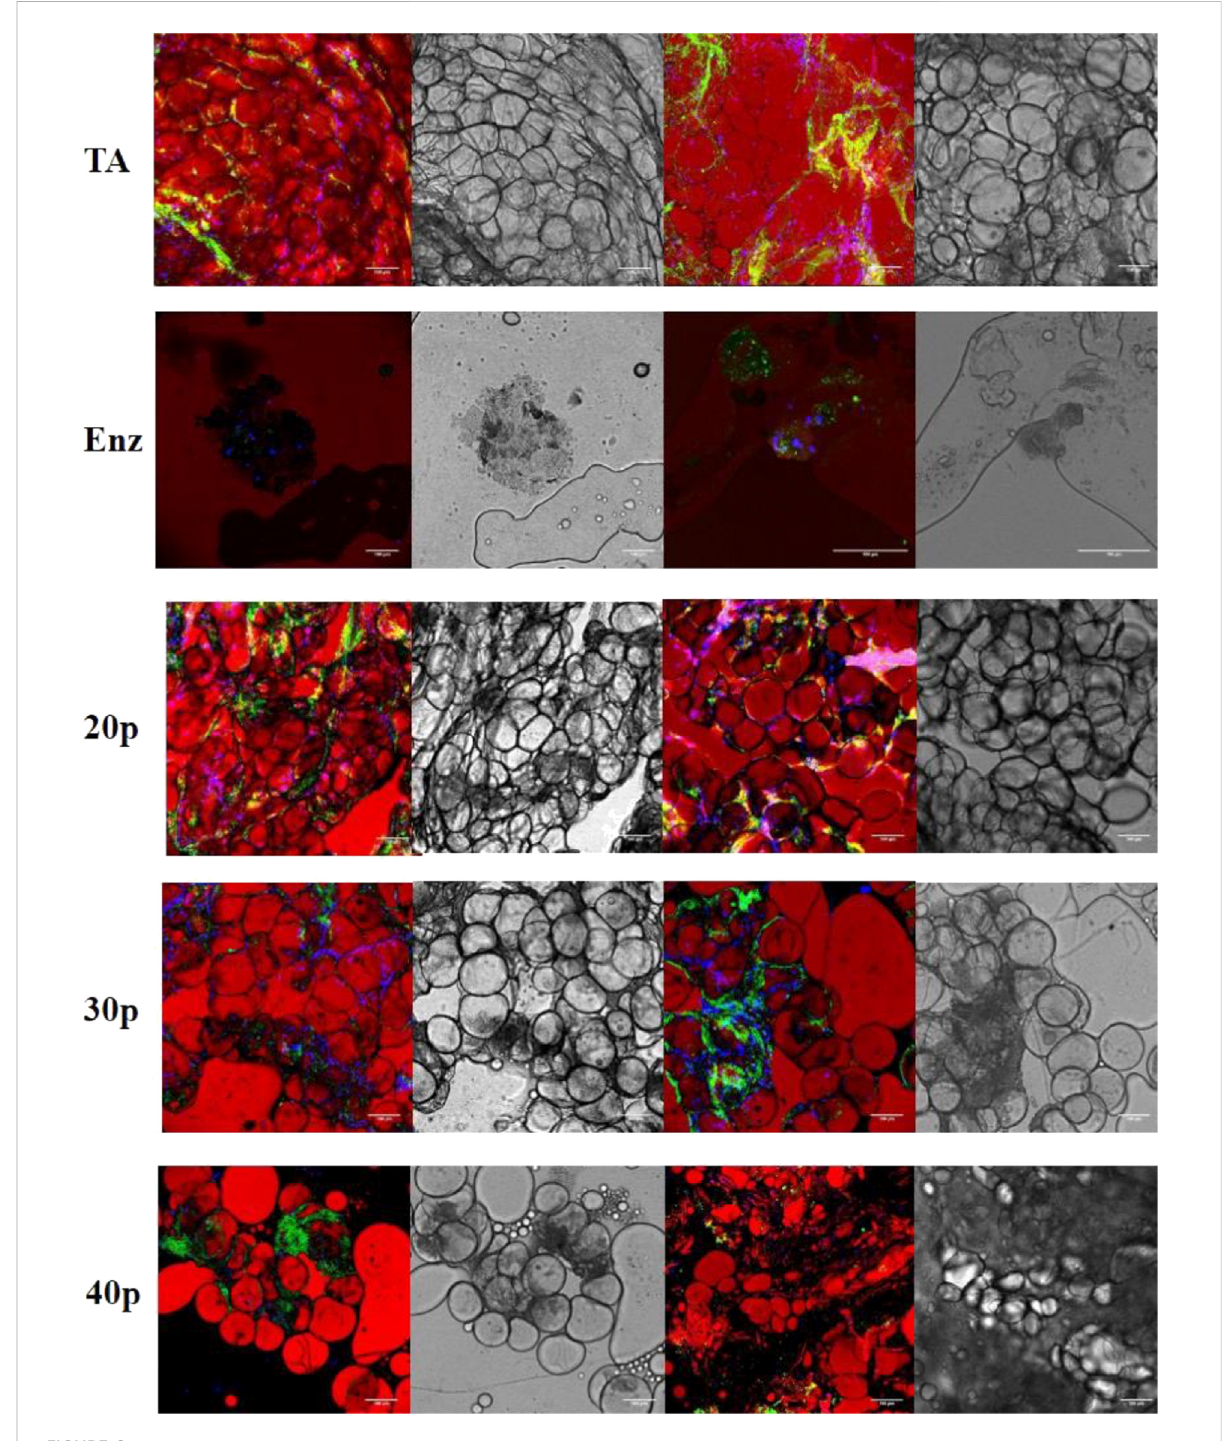
FIGURE 6 Immuno fl uorescence by confocal microscopy of the different SVFs. In red, adipocytes are stained by BODIPY; in green, endothelial cells are stained by isolectin coupledwith Alexa Fluor 488, and in blue, nucleated cells are stained by DAPI. Shades of gray: transmission electron microscopy imaging of the same section. * False positive, lipid vacuole. SVF: stromal vascular